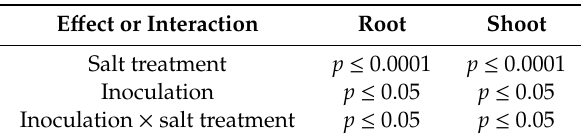
Table 5. Analysis of variance of ABA content in roots and shoots of wheat plants untreated with bacteria or inoculated with either B. subtilis IB-22 or P. mandelii IB-Ki14 (inoculation) grown in the presence and absence of NaCl (salt treatment). p values are presented for e ff ects of inoculation and salt-treatment and interaction of these factors (NS—non-significant). E ff ect or